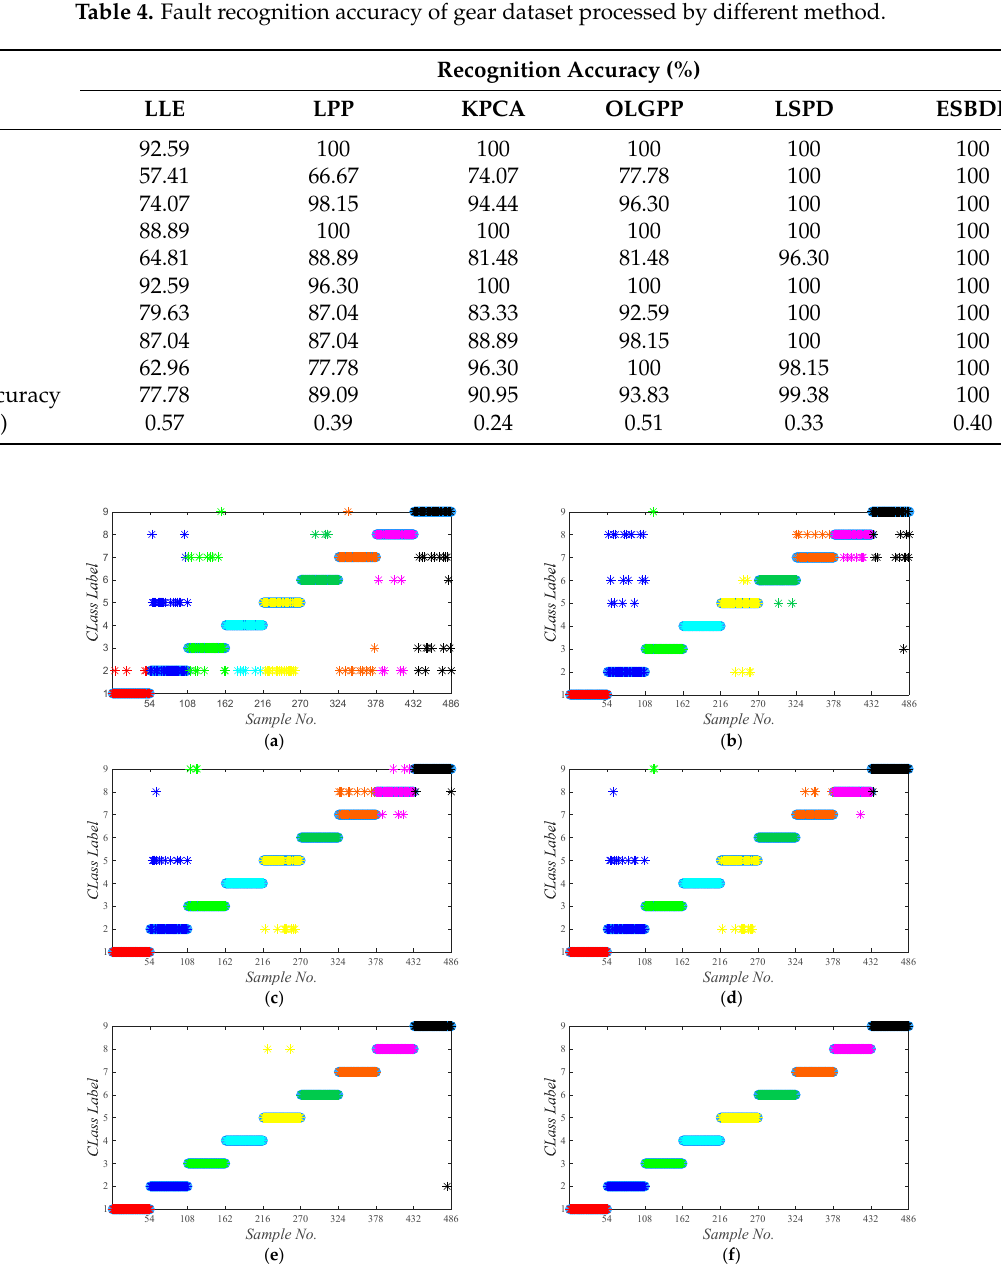
Figure 15. Three-dimensional distribution of test gear samples, where the different colors indicate different classes of samples. ( a ) LLE; ( b ) LPP; ( c ) KPCA; ( d ) OLGPP; ( e ) LSPD; ( f ) ESBDP.